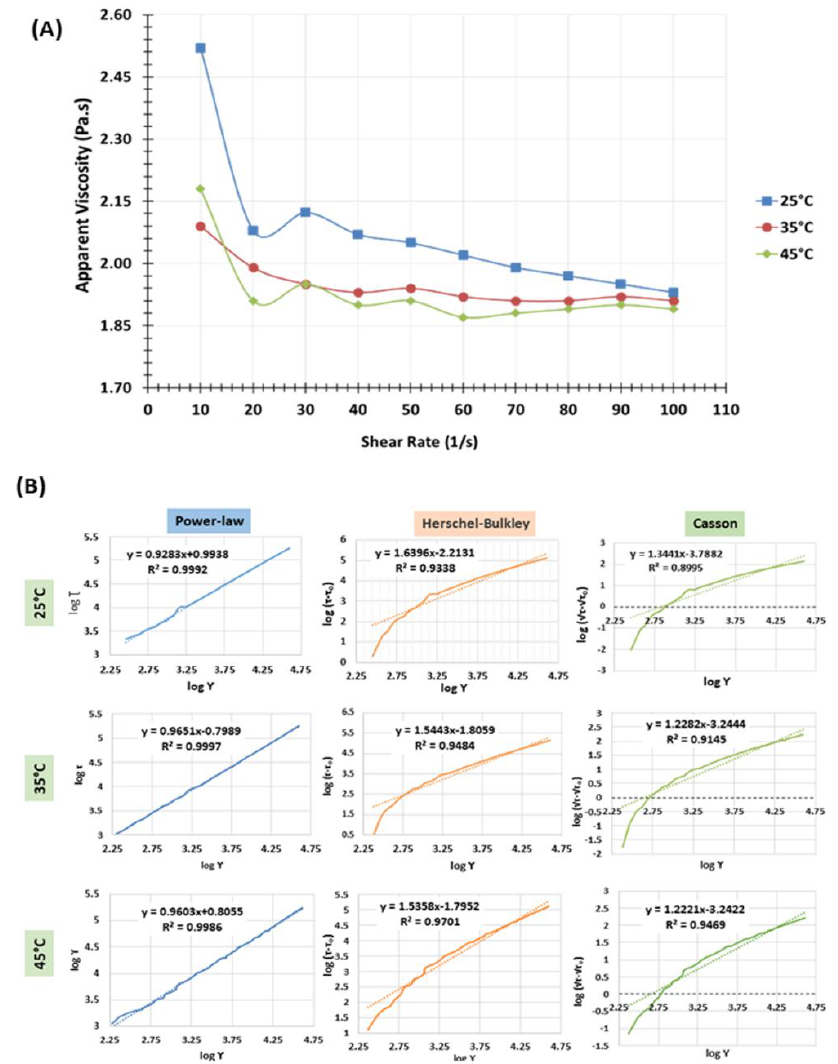
Figure 2. Rheological models of kappa-carrageenan-based electrospinning solution. ( A ): Apparent viscosity of electrospinning solution at three temperatures; ( B ): Fitting of mathematical models to describe the flow behavior of electrospinning solutions at three temperatures.